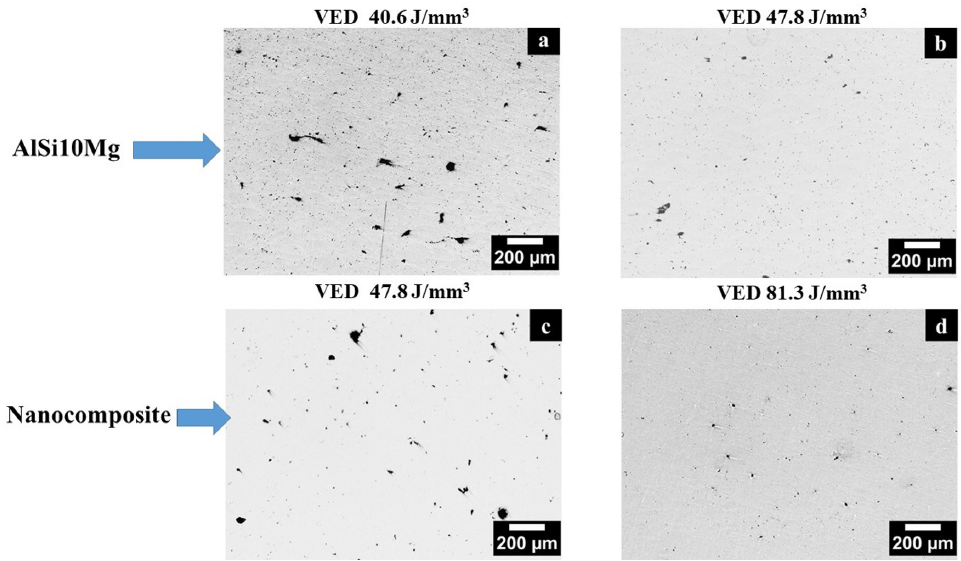
Figure 2. Optical images of the polished cross section of: ( a ) AlSi10Mg alloy built using a VED of 40.6 J/mm 3 ; ( b ) AlSi10Mg built using the standard VED of 47.8 J/mm 3 ; ( c ) nanocomposites built using a VED of 47.8 J/mm 3 ; ( d ) nanocomposite built using the chosen VED of 81.3 J/mm 3 .